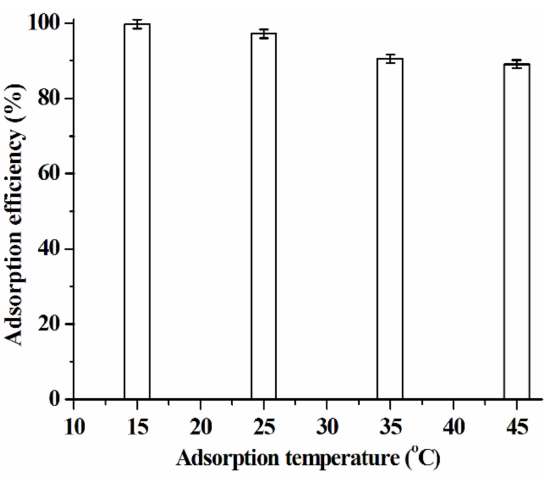
Figure 10. Effect of temperature on the adsorption efficiency of [C 3 mim] + Cl − @SiO 2 . Experimental conditions: C baicalin = 5.0 × 10 − 5 mol · L − 1 ; [C 3 mim] + Cl − @SiO 2 , 40 mg; volume of baicalin aqueous solution, 10 mL; adsorption time, 10 min; pH 5.0. Experiments were conducted in